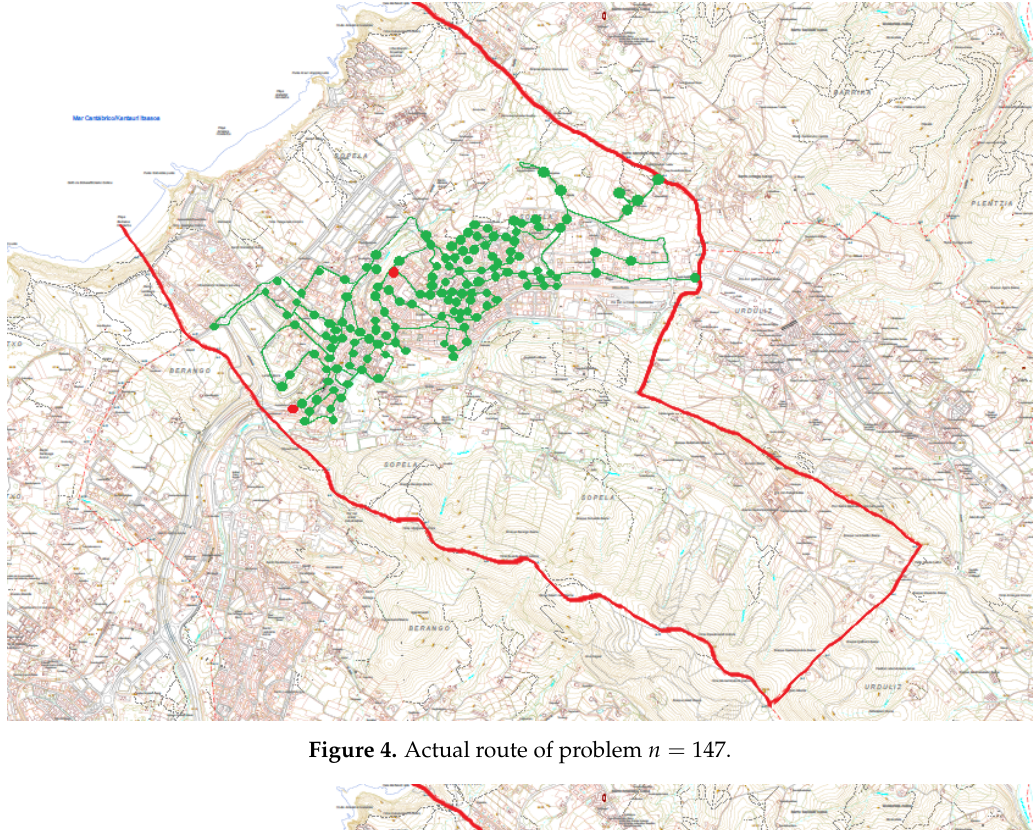
Figure 4. Actual route of problem n = 147.